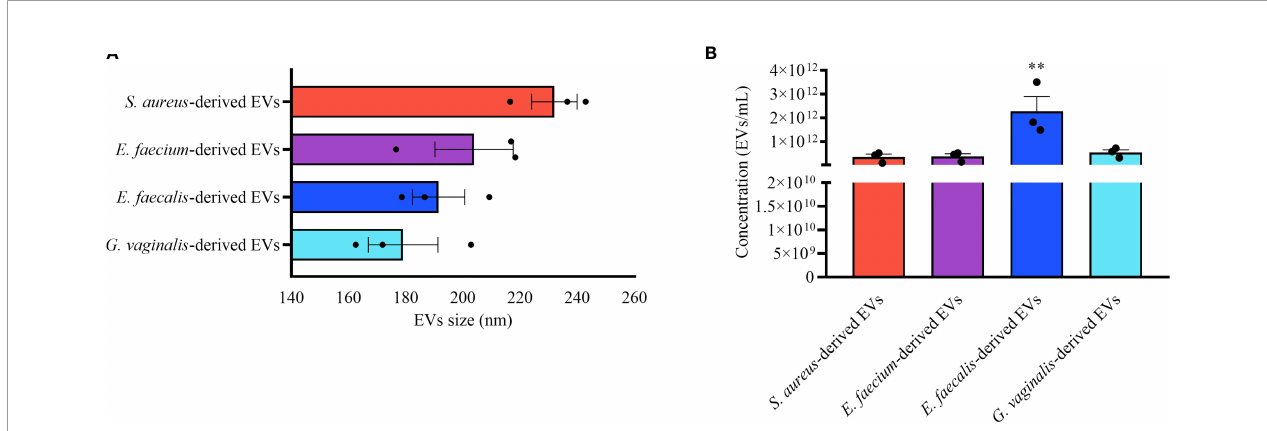
FIGURE 1 | Bacterial EV-size and concentration. Nanoparticle tracking analysis of EVs derived from S. aureus, E. faecium, E. faecalis , and G. vaginalis . (A) EV-sizes expressed as mean ± SEM of particle diameter (nm). (B) Mean ± SEM of the EV concentration (particles/mL). Presented are the results of three independent measurements. **p <